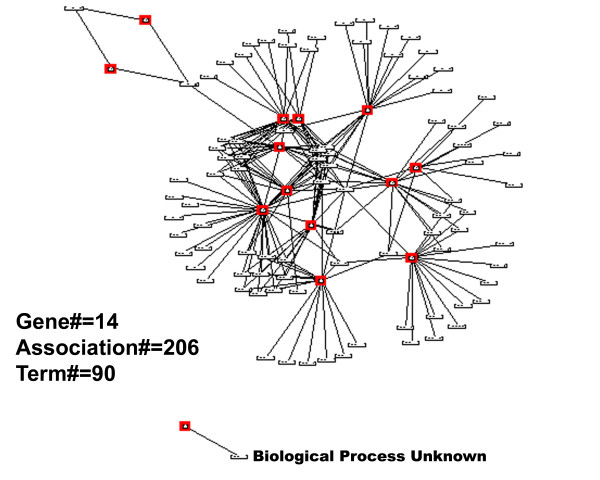
Graphical display of a gene-term association network (GTAN) within WPS. A GTAN was created based on the searched result from Fig. 8. The numbers of gene, association, and terms in this GTAN are indicated. All the genes in the network are highlighted in red. The rest of the tags in the network are pathway tags representing pathways/terms. The lines linked the genes and associated terms indicated the associations (Note: This diagram is to show the whole layout of the network. When running WPS, the legends of genes and pathway tags can be visibly seen when mouse is placed on top of the tags even if they are not visible in this diagram.)